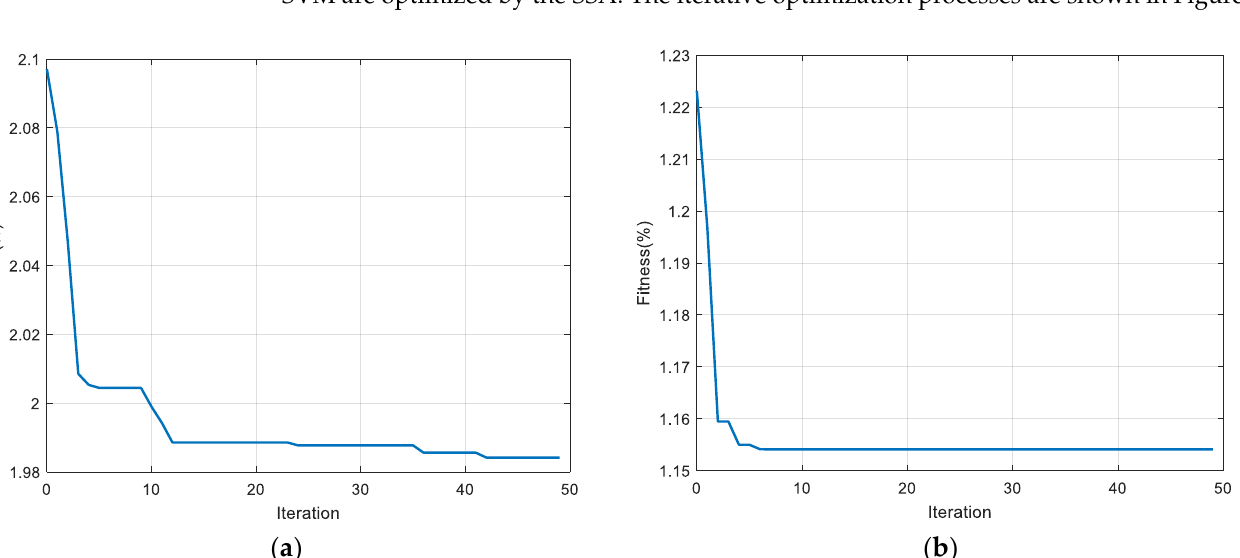
Table 1. The optimized penalty coefficient and width factor of SVM in the proposed method.